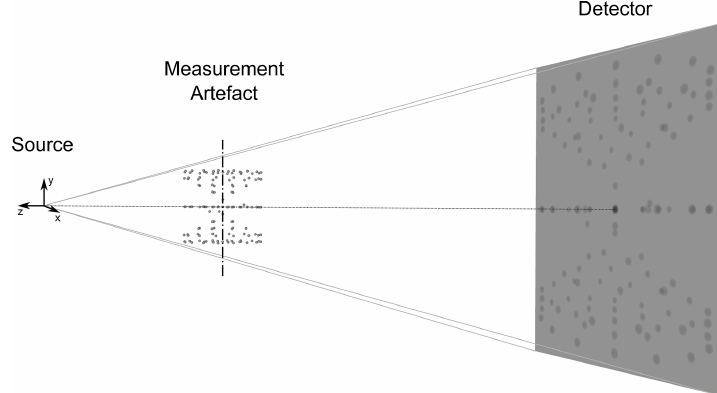
Figure 2. Illustration of the acquisition geometry along with the coordinate system used. The negative z axis is the beam direction, the y axis is parallel to the axis of rotation and the x axis is the second direction along the detector (besides the y axis). The rotation axis almost coincides with the axis of the measurement artefact and has its pivot point below the beam cone to model a real CT system realistically. The source is an isotropic point source.